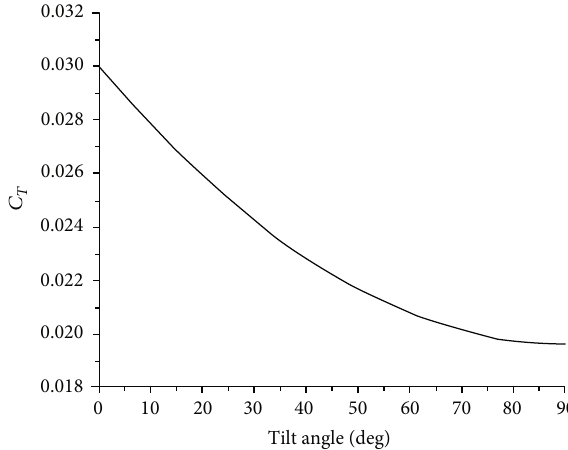
Figure 14: Rotor thrust coe ffi cient